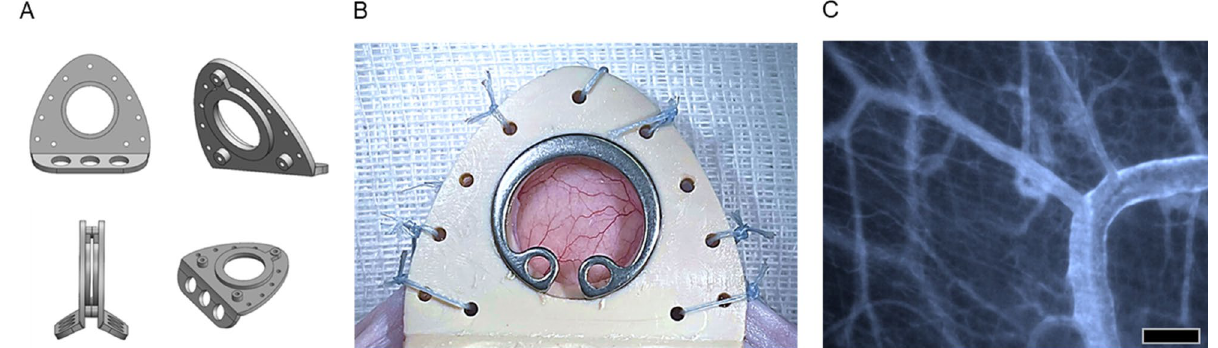
Figure 2. Exemplary design of the PEEK chamber. ( A ) Model of the scaled-down and 3D-printable PEEK chamber (created with SolidWorks). ( B ) The extrusion printed PEEK chamber was ground to remove superficial irregularities and implantated into the test animal. ( C ) Representative intravital microscopy image of a PEEK chamber on day 3. Bar represents 100